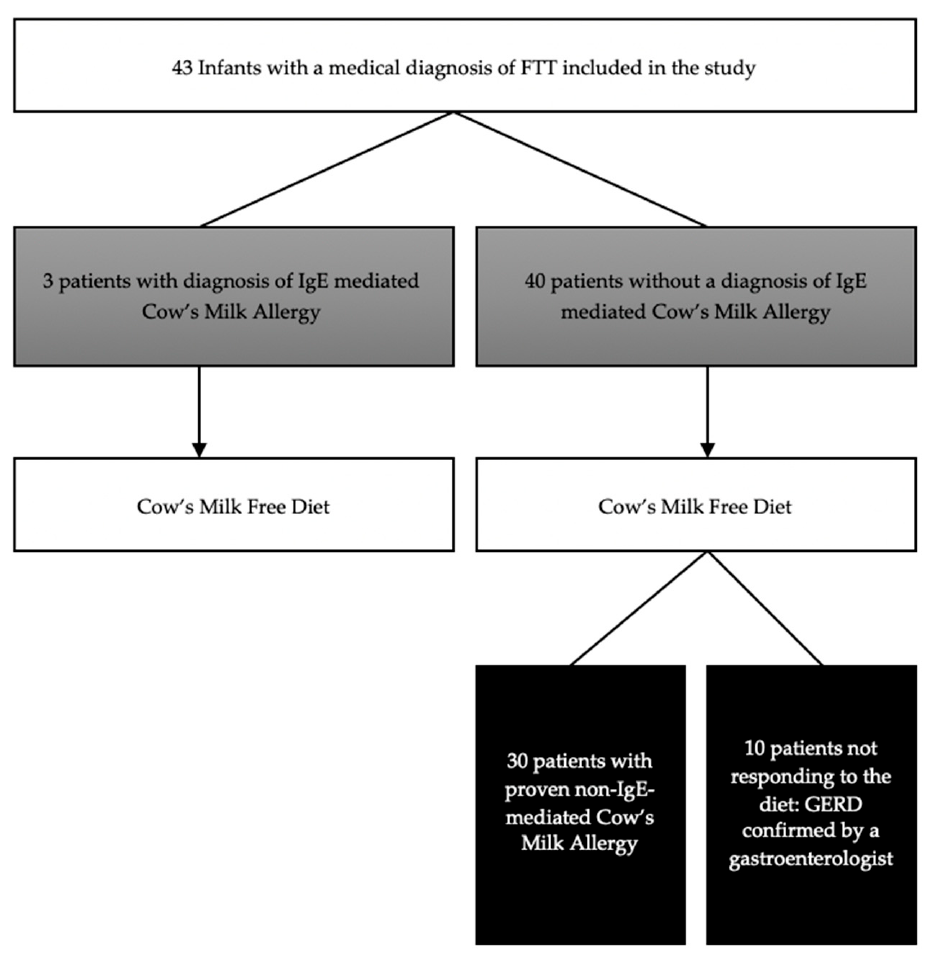
Figure 2. Flow chart showing the diagnosis reached in the 43 included patients (GERD: gastro esophageal reflux disease).